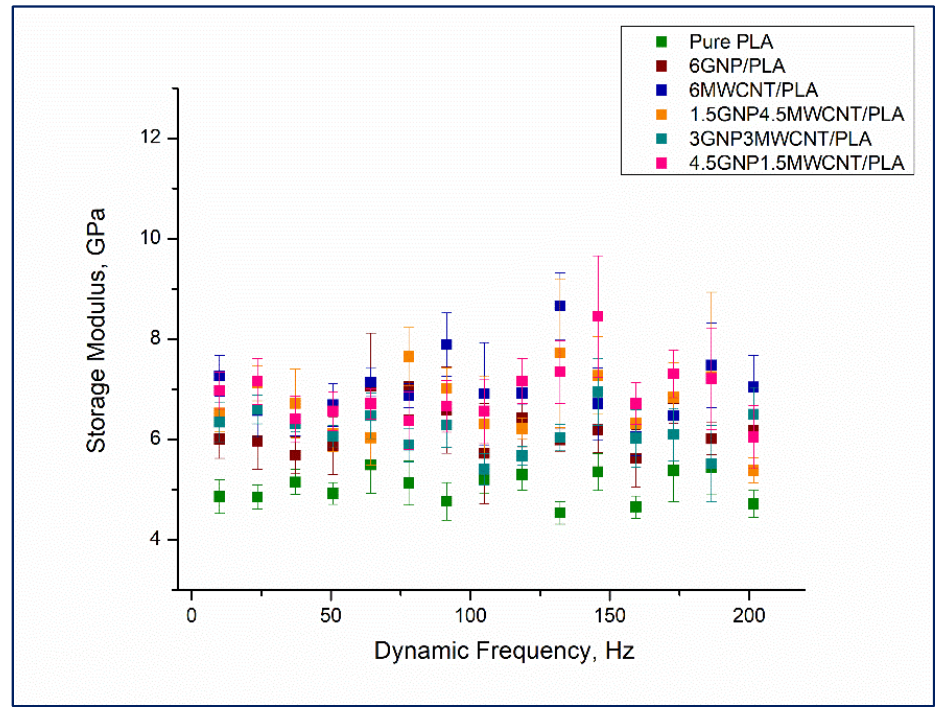
Figure 8. Storage modulus versus dynamic frequency for the whole series of nanocomposite samples including neat PLA.